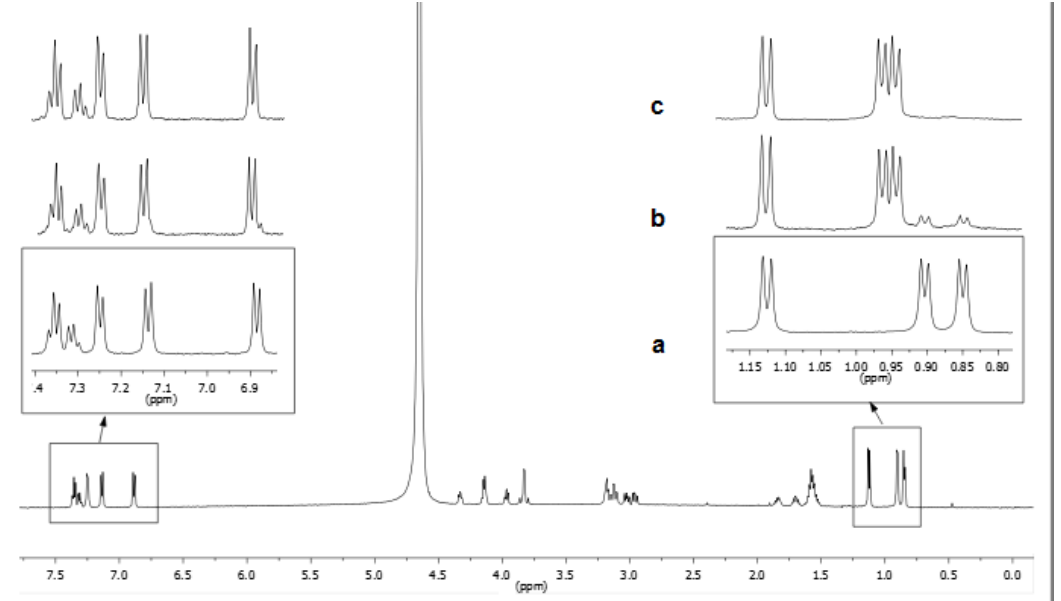
Figure 7. 1 H NMR spectra (600 MHz, D 2 O, phosphate buffer, pH = 6.8, 37 °C) of pure DAL (0.68 mM, ( a ) and of the DAL/CHT after 5 min ( b ) and 14 min ( c ).